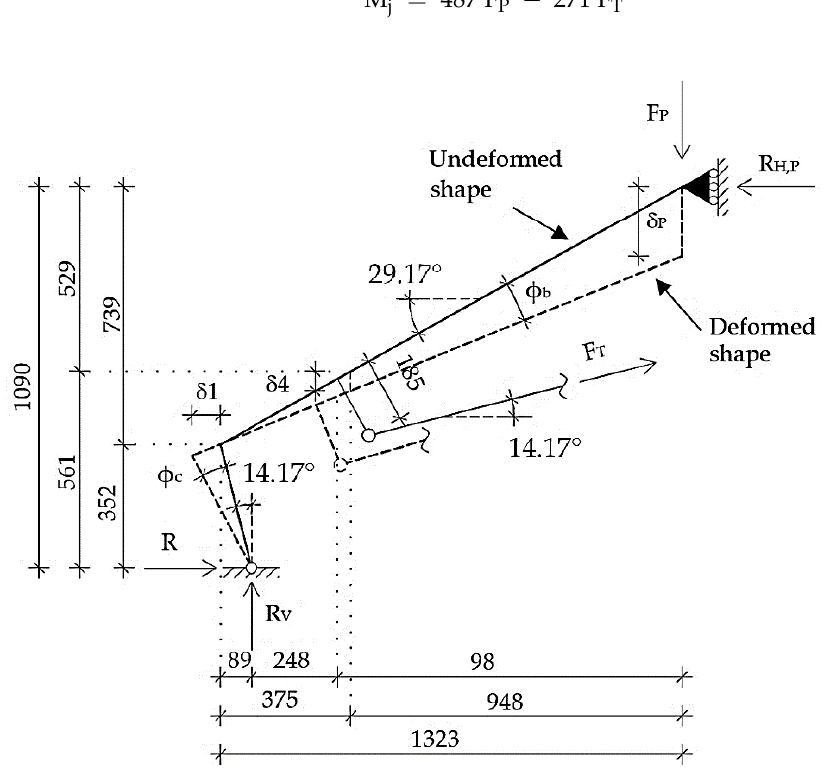
Figure 8. Loading and boundary conditions of the steel knee specimen (dimensions in